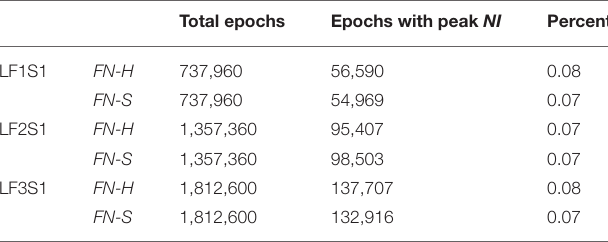
TABLE 1 | Incidence of periods of uncertainty at the EEG frequency level.